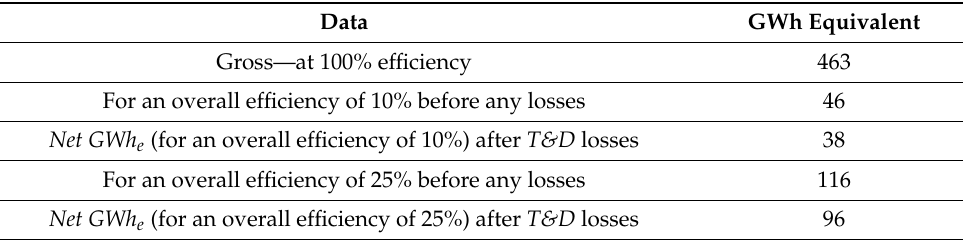
Table 12. Summary of the electrical generation potential from urban human waste.